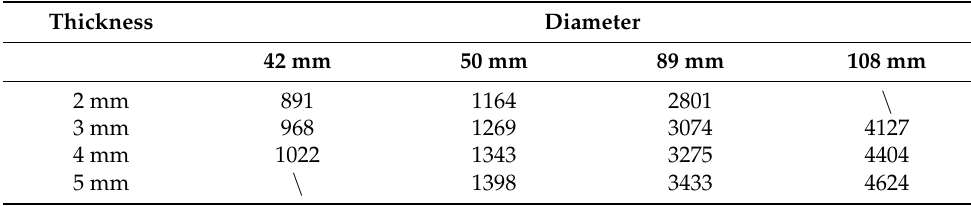
Table 4. Lateral stiffness of each type of FLSP (unit: kN/m).